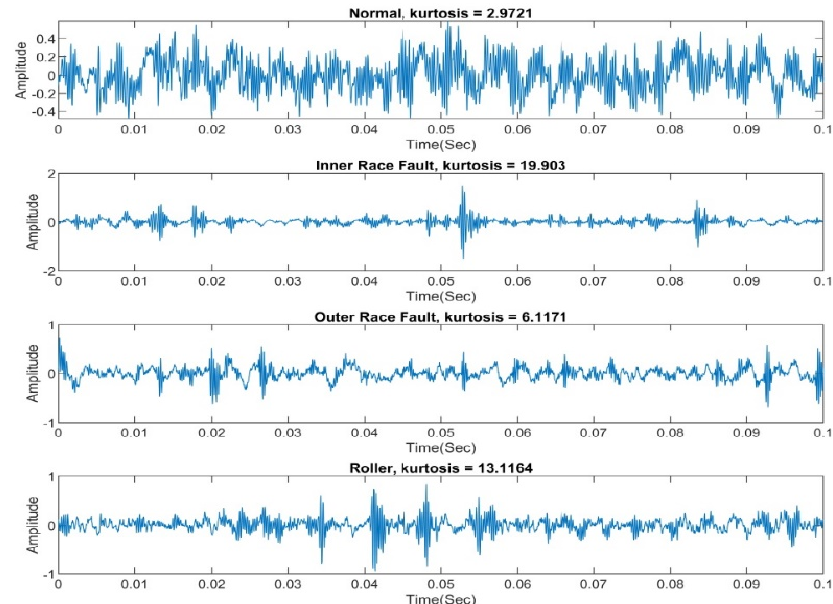
Figure 6. Kurtosis value for different bearing conditions.